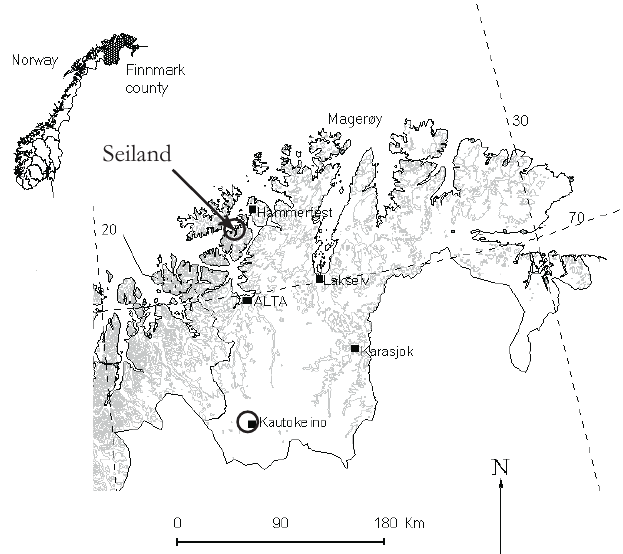
Fig. 1. Sampling locations at coast and inland areas. The sum- mer range was at Seiland island in Altafjord (70.25°N, 23.15°E) and the winter range around Kautokeino (68.60°N,